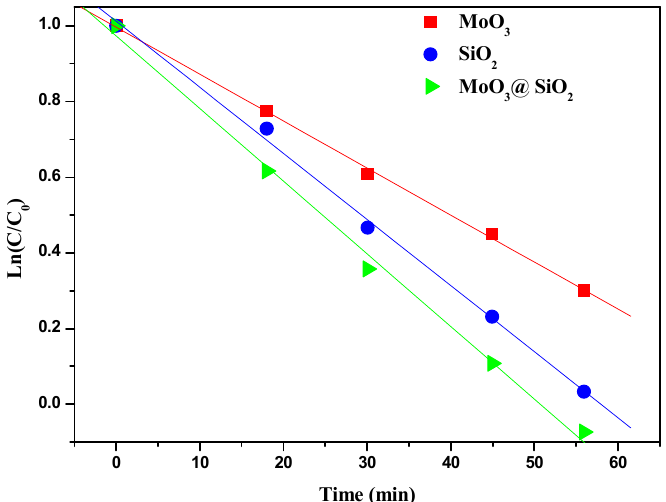
Figure 6. The plots of Ln ( C / C 0 ) versus time for MoO 3 , SiO 2, and MoO 3 @SiO 2 .